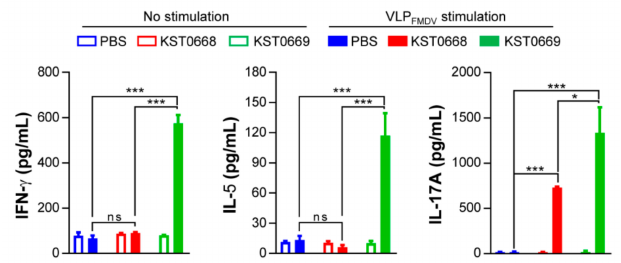
Figure 6. VLP FMDV -specific cytokine production in spleen cells of vaccinated mice. Mice ( n = 5